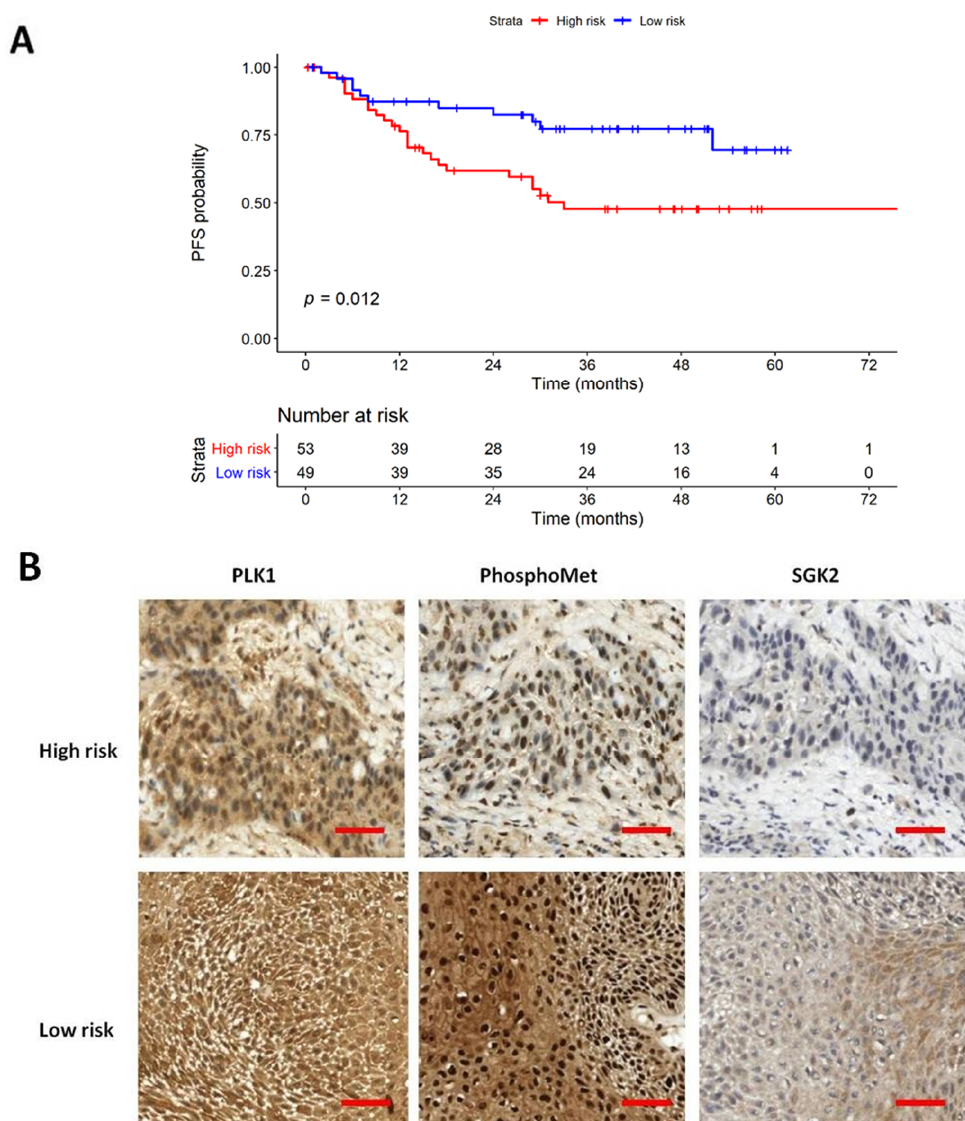
Figure 3. Kaplan–Meier plot of progression-free survival (PFS). ( A ) PFS results stratified by 8th protein staining cluster. ( B ) IHC staining of 8th protein staining cluster of high-risk and low-risk patients, respectively. The scale bar showed 200 μm in distance (magnification 400×).